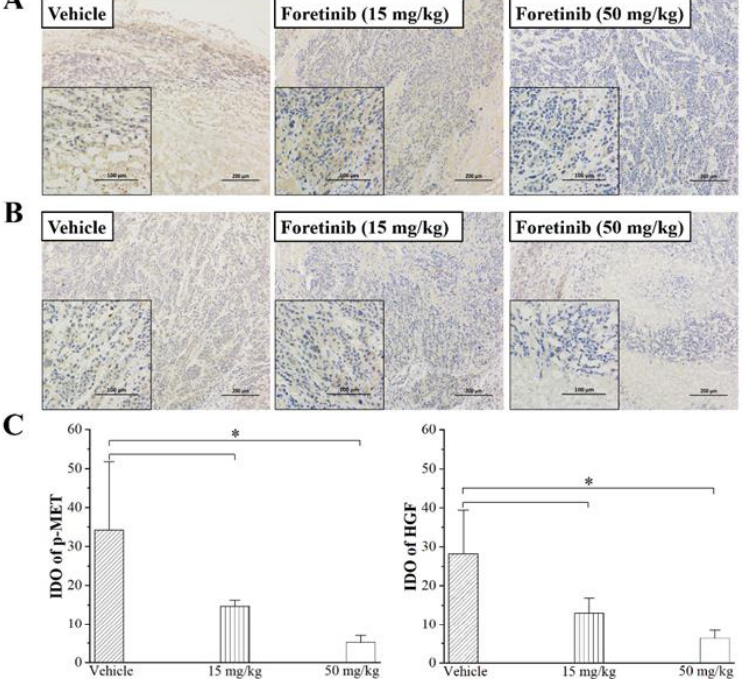
Figure 4. Immunostaining on tumor paraffin sections from mice treated with vehicle and foretinib (15 and 50 mg/kg) for 18 days demonstrated the reduction of p-MET ( A ) and HGF ( B ) by foretinib. The brown staining intensity represents the expression of p-MET and HGF in the cytosol of tumors, and the blue staining represents the cell nucleus. The original magnification is 100× and 200× for all panels. ( C ) Quantitative analysis of IODs of anti-p-MET (left) and anti-HGF (right) immunohisto- chemical staining at the different dosages. Magnification, 200×. *, p < 0.05. IOD, integrated optical density.